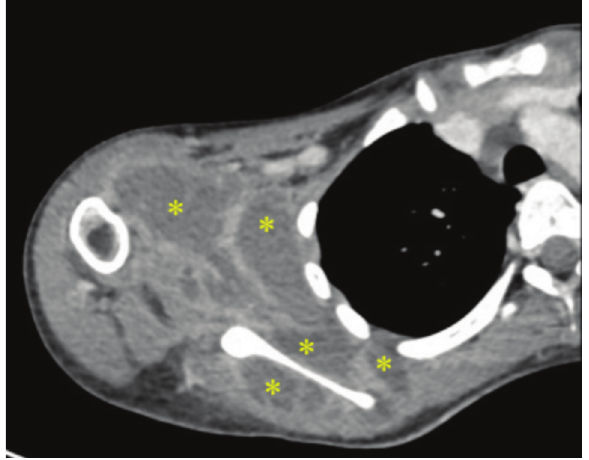
Swelling at right scapular region. Fig. 1: